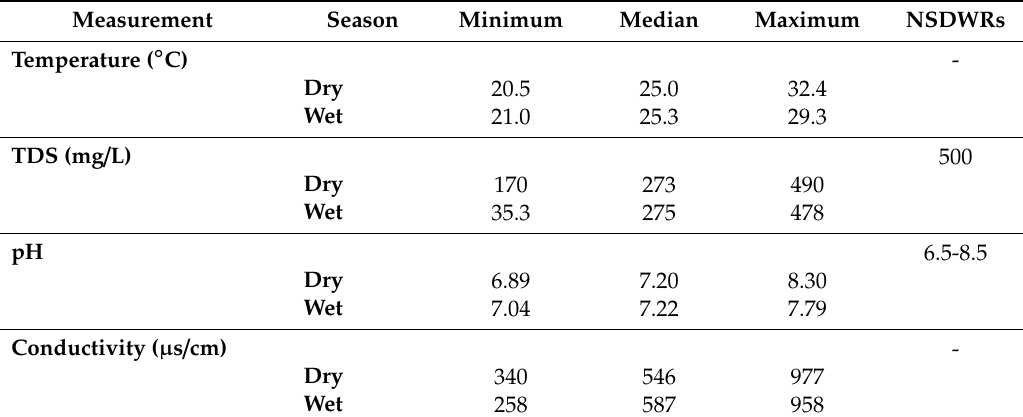
Table 2. Water quality measurements in well water by